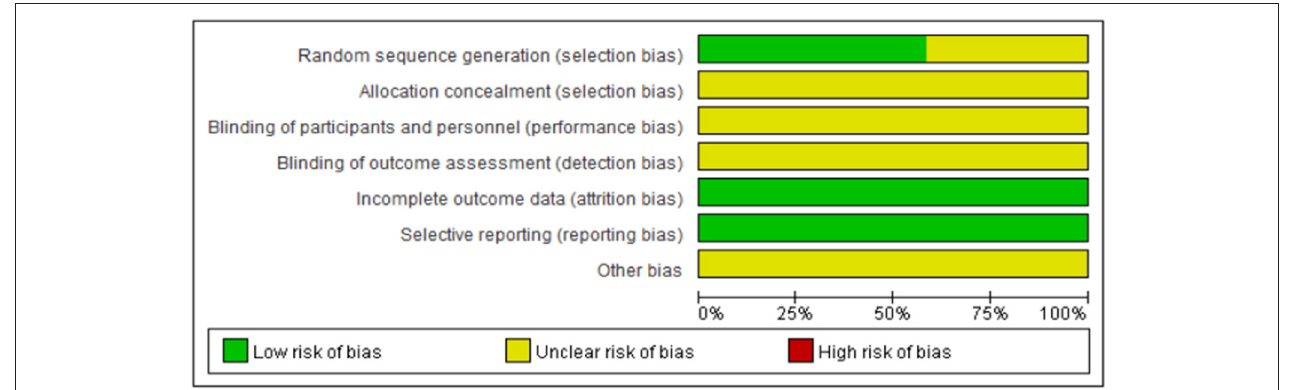
FIGURE 2 | Risk of bias graph.